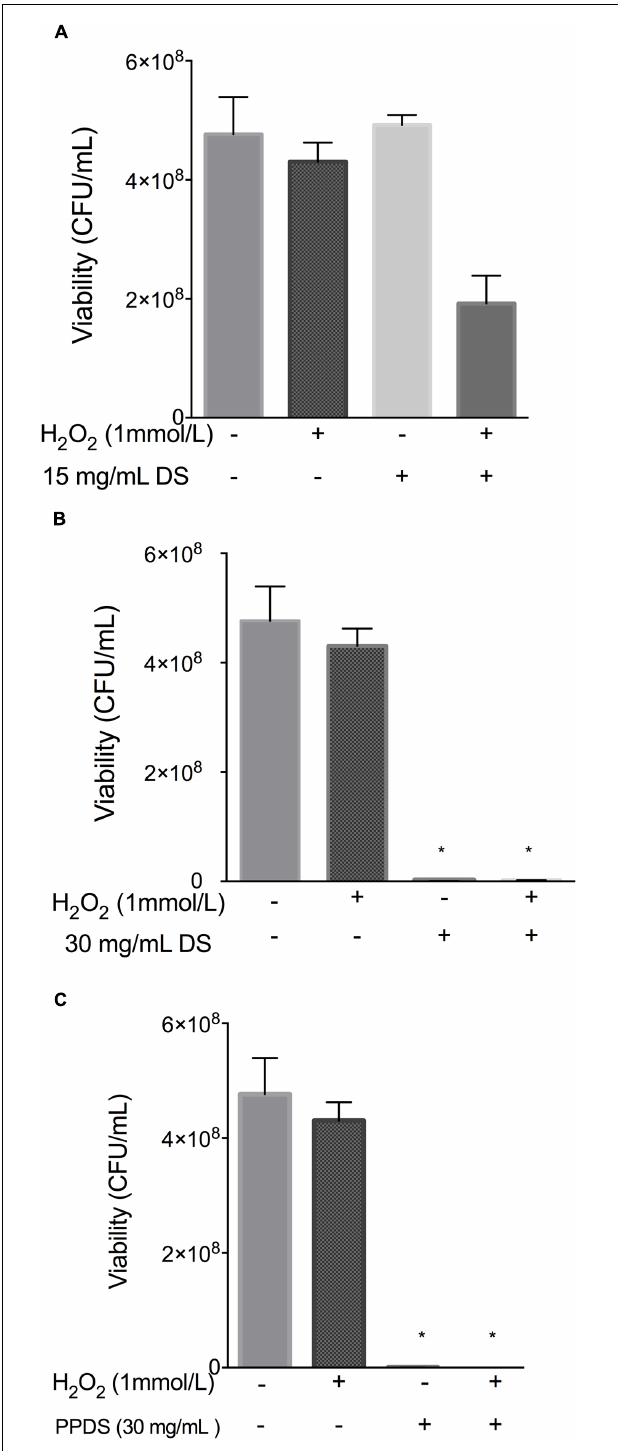
FIGURE 4 | Evaluation of antioxidant activity of DS treatments. (A) 15 mg/mL DS, (B) 30 mg/mL DS, and (C) polyphenol DS (PPDS)(30 mg/mL). DS treatments were added to NB medium and incubated at 37 ◦ C with E. coli for 4 h with shaking, cell viability was determined using the surface drop count method and expressed as viability in CFU. Significant differences between treatment groups are indicated as ∗ p <